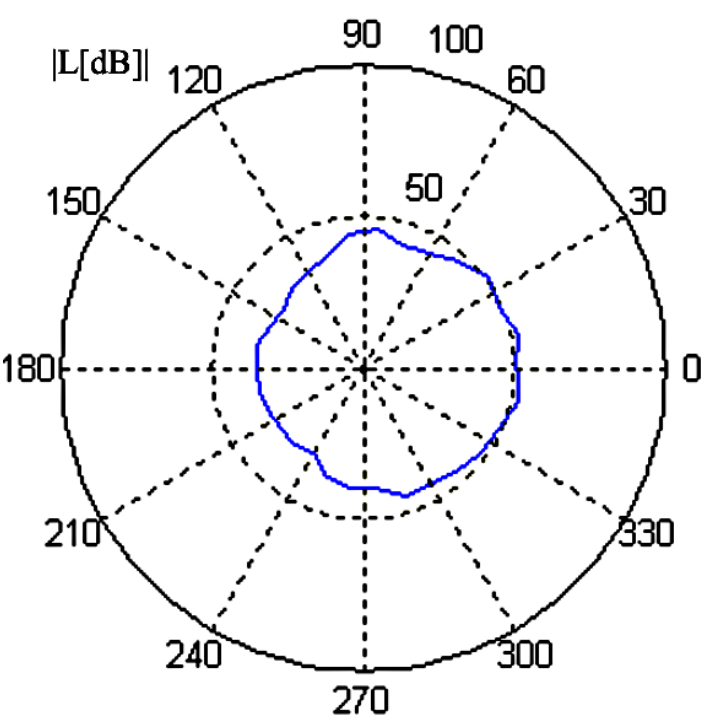
Figure 18. High level of noise position at 120 degrees